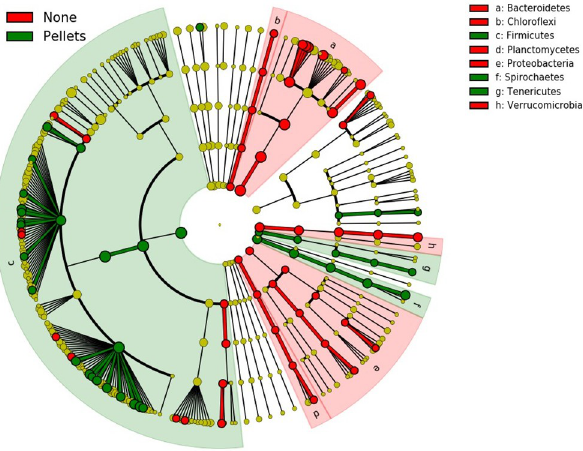
Fig 7. Linear discriminate analysis effect size (LEfSe) results showing bacterial lineages that differed significantly in a population before and after supplemental feeding with concentrated alfalfa pellets. Each node in the tree represents a taxon from phylum level through genus level (tips). Nodes are colored red if they were enriched under the natural diet regime, and green if they were enriched under the pelleted feed regime. Yellow nodes did not differ significantly across regimes. Branches are highlighted red if they belong to phyla that were enriched under the natural diet regime, and green if they belong to phyla that were enriched in pellet-fed elk.